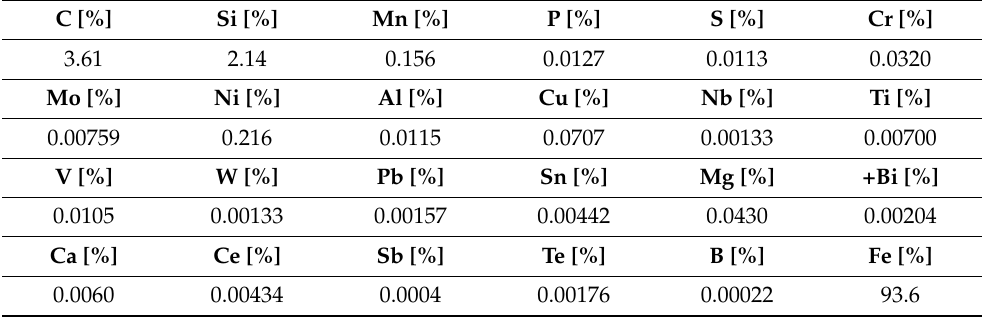
Table 4. Chemical analysis of the sample made of gray cast iron with lamellar graphite type EN-GJL-250.